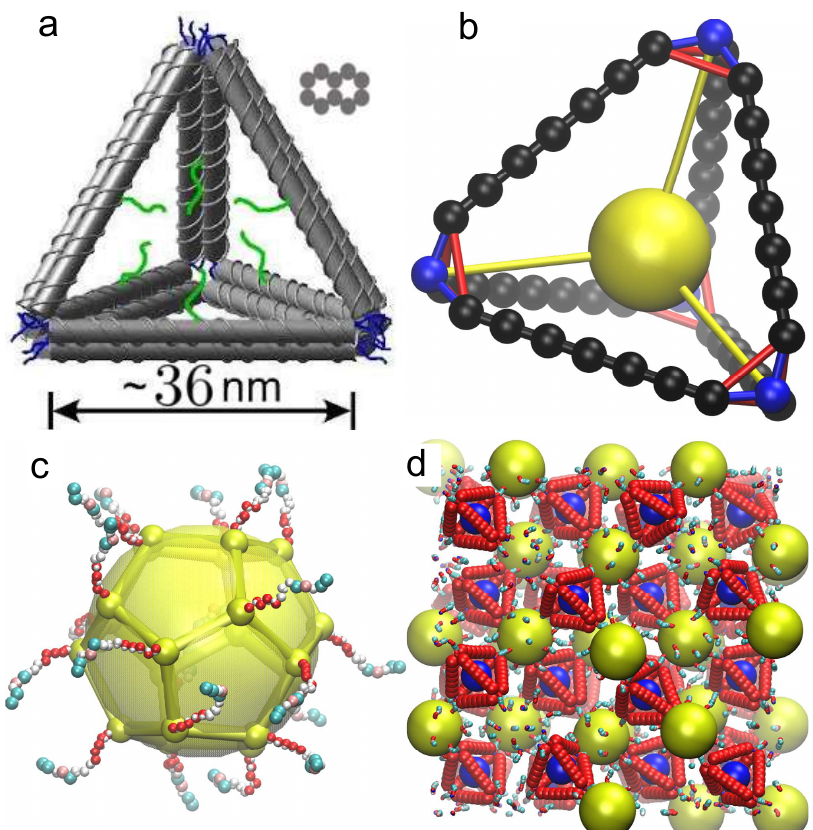
Figure 1. ( a ) Schematic of the tetrahedral cage used in previous experiments [28]. Each dsDNA in the tetrahedral edge is represented by gray cylinder. The figure also shows the cross-section of an edge to indicate relative positions of ten dsDNA bundles. The blue lines indicate ssDNA linkers at the vertices, and the green lines are the ssDNA linkers used to attach a NP at the cage core. ( b ) Schematic of tetrahedral cage bond structure used in the MD simulation. The spheres show the particle positions and the lines show the bonds between particles. Different colors shows different bonds explained in the main text. The sphere sizes are not representative of the actual size of particles. ( c ) The schematic of NP used in the MD simulation. Small spheres show the position of the vertices, and the large sphere shows the central particles and the lines show the bonds between vertices. ( d ) A simulation snapshot of the full lattice structure; the edges appear “ragged” owing to the representation of periodic boundary